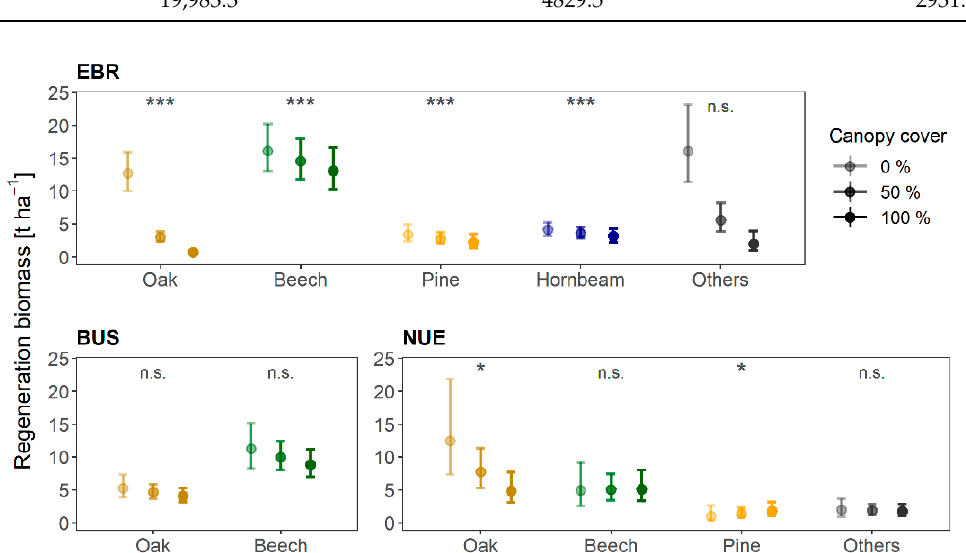
Figure 4. Regenerated biomass of oak, beech, pine, hornbeam, and other broadleaf tree species as a function of canopy cover at the age of 30 (Equation (4)); asterisks denote the significance levels of the canopy cover effect, *** p < 0.001, * p < 0.05, n.s. not significant.